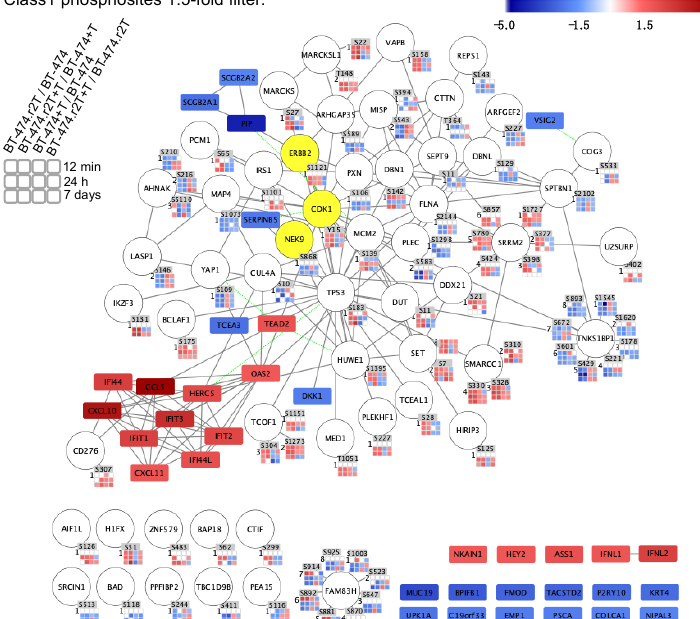
Figure 3. Multi-omic study identified up- and downregulated candidates in acquired trastuzumab-resistant BT-474.r2T cells compared to parental sensitive BT-474 cells. Prediction map of molecular interactions among candidates involved in our model of acquired resistance to trastuzumab, according to phosphorylation signals of the identified candidates by SILAC phosphoproteomic analysis (≥ two out of three overlaps, ≥ 1.5-fold change) and mRNA expression microarrays (BT-474 vs. BT-474.r2T cells, both untreated and treated with trastuzumab, ≥ 2-fold change). Ellipse nodes shows identified proteins. Phosphorylated residues are indicated, and squares show quantification time points for SILAC experiments; rectangle shows identified mRNAs. Negative regulation (blue scale: 43 Class 1 phosphosites, 19 mRNAs) and positive regulation (red scale: 43 Class 1 phosphosites, 16 mRNAs) are indicated; yellow-labeled nodes show the known kinases identified; white-labelled time points shows missing values.